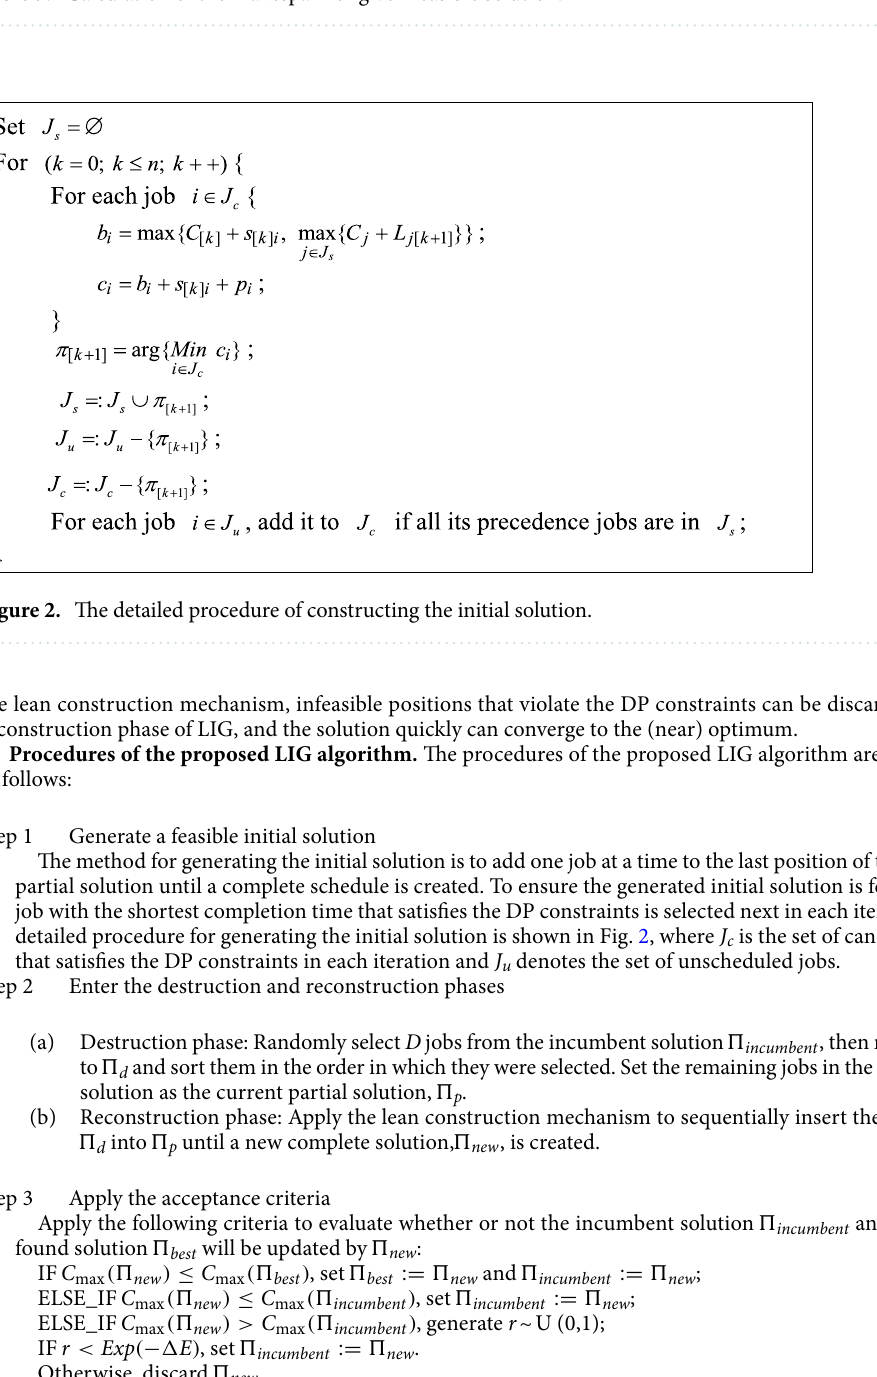
Table 5. Calculation of the makespan for given feasible solution.